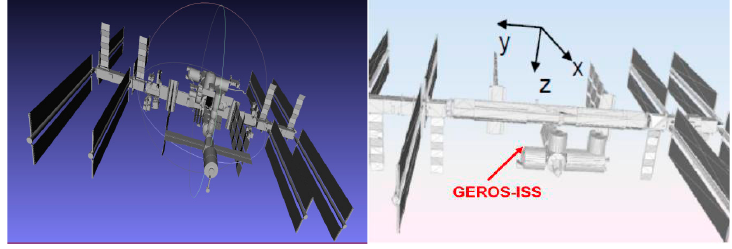
Figure 8. Simplified ISS model and reference frame used.